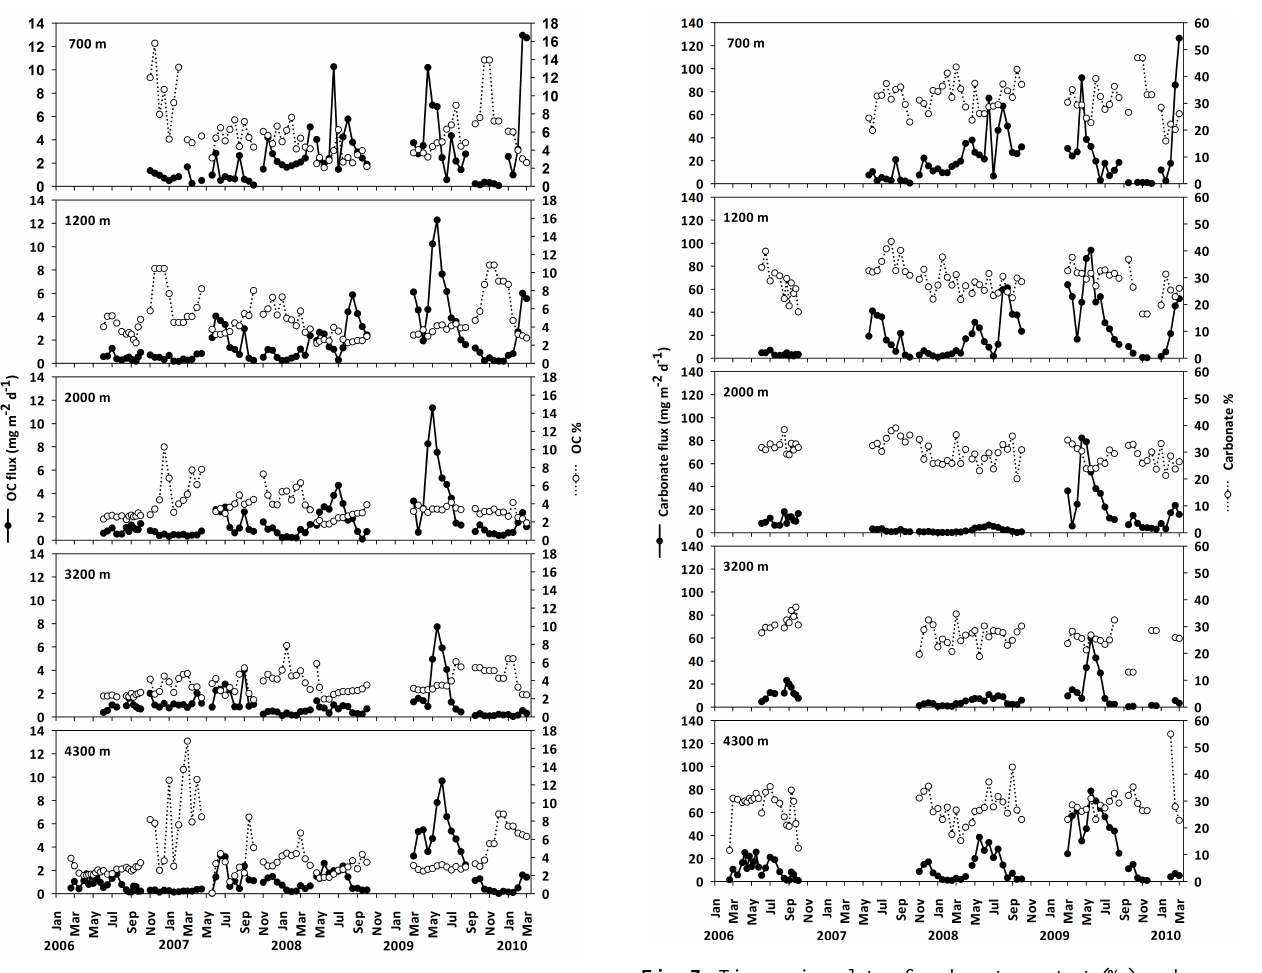
Fig. 6. Time-series plots of organic carbon content (%) and fluxes (mgm − 2 d − 1 ) of downward settling particles collected by sediment traps during the course of the long-term experiment in NESTOR site.